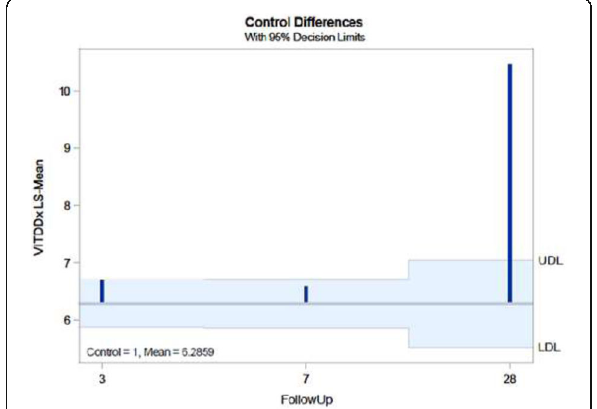
Fig. 1 (abstract 0045). Postoperative variation of vitamin D